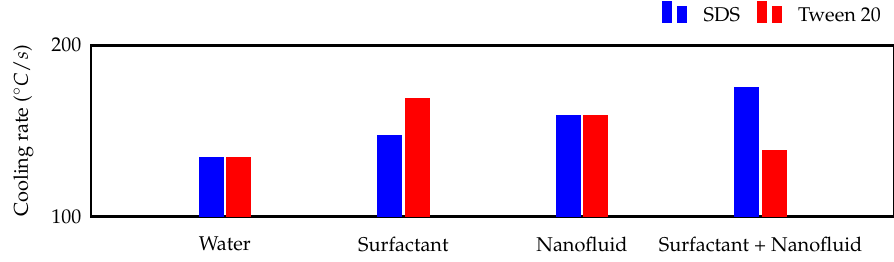
Figure 14. Overall effect of the surfactants on cooling performance. Graph is reconstructed from